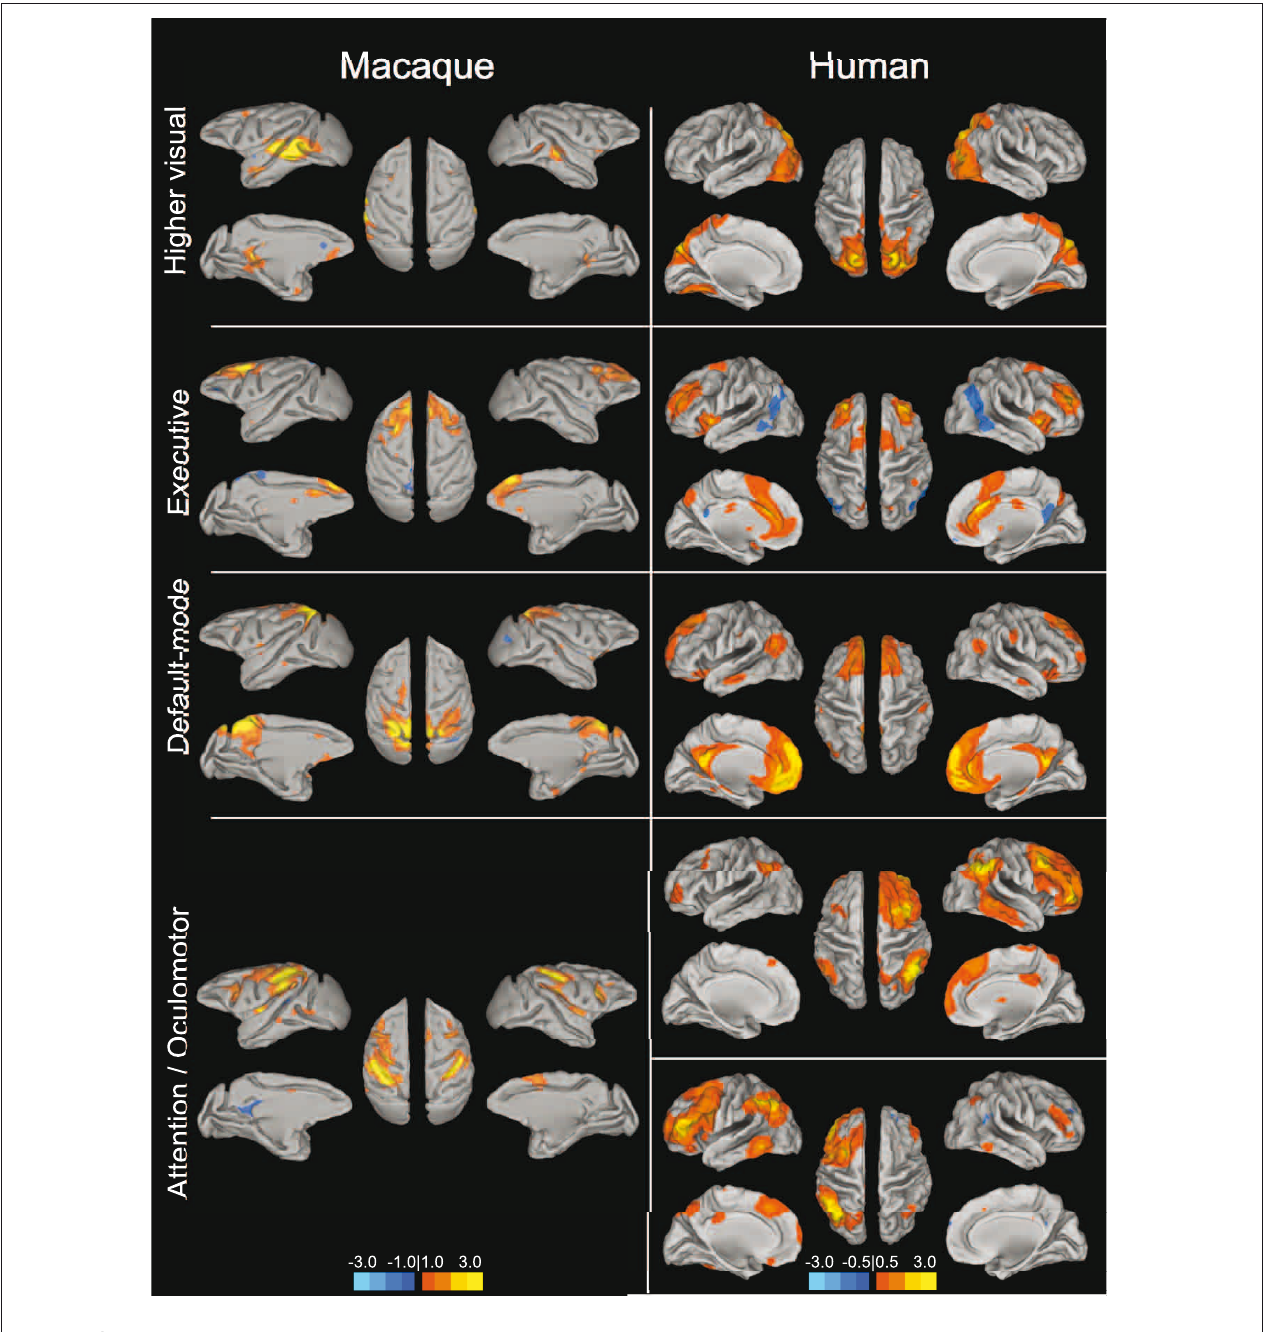
FIGURE 2 | Homologous higher-order resting-state networks of the macaque (left column) and human (right column). Putative functional roles of the networks are indicated on the left. Macaque networks